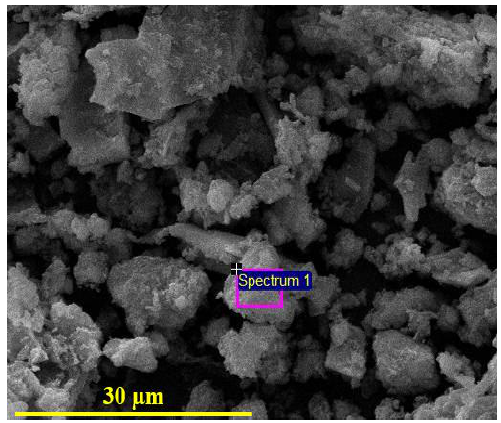
Figure 3. Scanning electron microscopic image of developed organic fertilizer